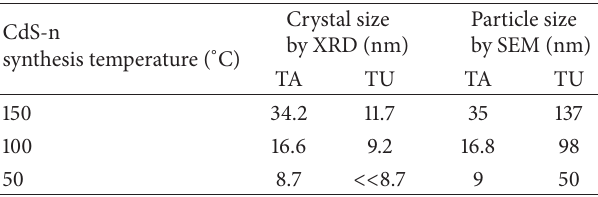
Table 1: Crystallite and particle sizes of CdS-n(TA) and CdS-n(TU) products, synthesized at different temperatures, measured by XRD and SEM,